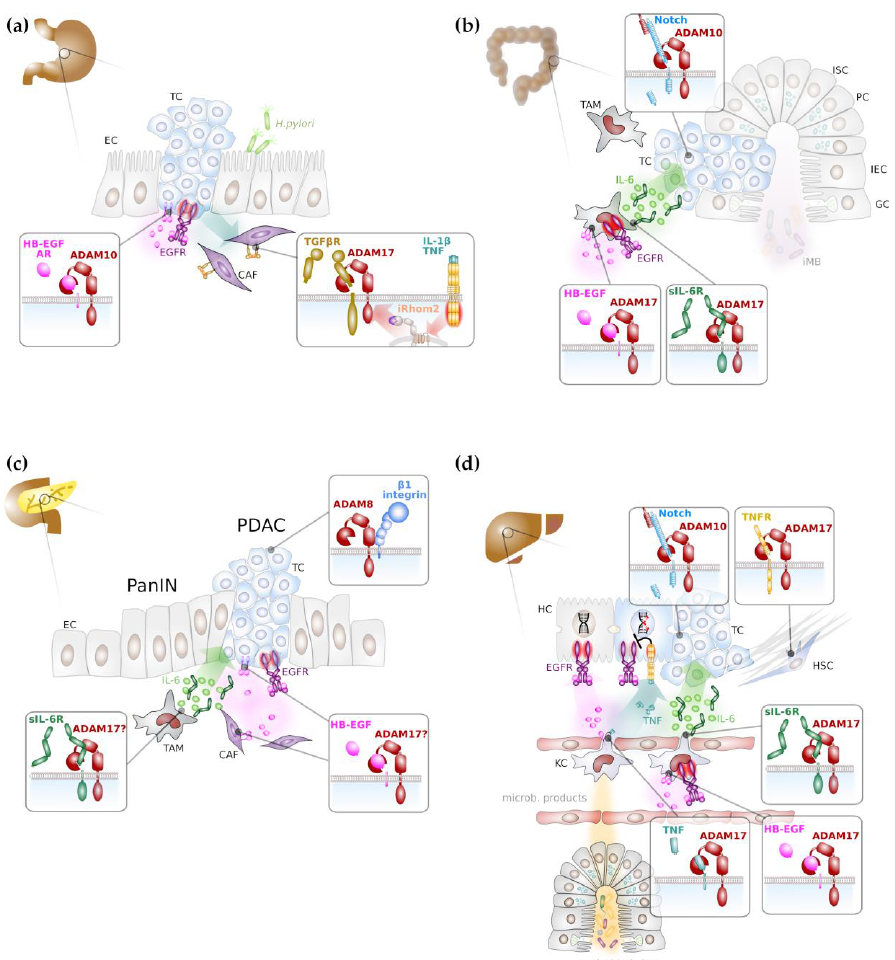
Figure 2. Major ADAM-mediated signalling pathways in gastrointestinal cancer formation. ( a ) ADAM proteases in particular ADAM10 and ADAM17 promote gastric tumorigenesis mainly through activation of epidermal growth factor (EGF) receptor (EGFR) signalling on cancer cells and through inhibition of transforming growth factor (TGF) β receptor (TGFβR), thereby enhancing motility of cancer-associated fibroblasts (in purple). ( b ) Colonic tumorigenesis depends on Notch signalling promoted by ADAM10. In addition, myeloid ADAM17 is supposed to promote inflammatory signalling via proteolytic release of EGFR ligands, such as heparin-bound EGF (HB-EGF) and concomitant induction of interleukin (IL) 6 (green circles). In concert with the soluble IL-6 receptor (sIL-6R), IL-6 induces trans-signalling on colon epithelial cells. ( c ) EGFR signalling and IL-6 trans-signalling promotes progression of pancreatic intraepithelial neoplasia (PanIN) to pancreatic ductal adenocarcinoma (PDAC), presumably via ADAM17 activity. ( d ) DNA damage response (DDR) in hepatocytes is enhanced via EGFR signalling. Intestinal dysbiosis induces tumour necrosis factor (TNF) secretion from Kupffer cells (KCs), the liver-resident macrophages that impairs the beneficial effects of EGFR signalling on DDR. Both, EGFR ligands and TNF are presumably released by ADAM17 from KCs. Liver fibrosis is reduced by ADAM17 via impaired TNF receptor signalling in hepatic stellate cells. Hepatocarcinogenesis is promoted by IL-6 trans-signalling that is presumably induced by ADAM17 on KCs. Notch signalling mediated by ADAM10 in hepatocytes promotes hepatic tumorigenesis. Abbreviations: CAF: cancer associated fibroblast; EC: epithelial cell; GC: goblet cell; HSC: hepatic stellate cell; IEC: intestinal epithelial cell; iMB: intestinal microbiome ISC: intestinal stem cell; KC: Kup ff er cell; PC: Paneth cell; TAM: tumour associated macrophage; TC: tumour